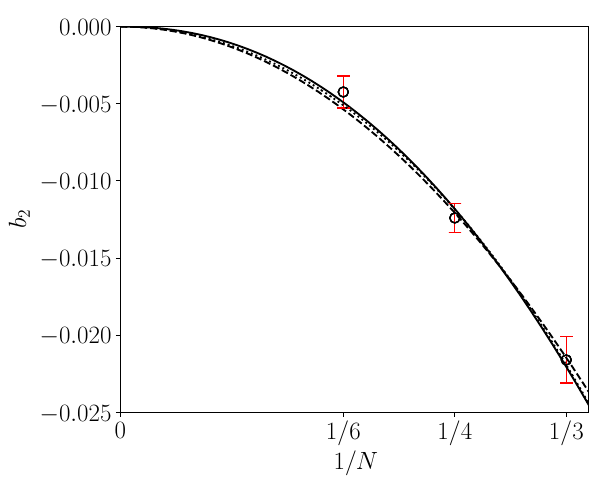
Figure 8 . Extrapolation of b obtained using fit function b 2 = ¯ b 2 /N c in the whole range; the dashed line represents the best fit obtained using the same fit function but with fixed c = 2 in the whole range; the dotted line represents the best fit obtained in the whole range including a further ¯ b (1) function. The best fits yield, respectively, ¯ b 2 = exponent results c = 2 . 17(26), while the next-to-leading correction is ¯ b (1)